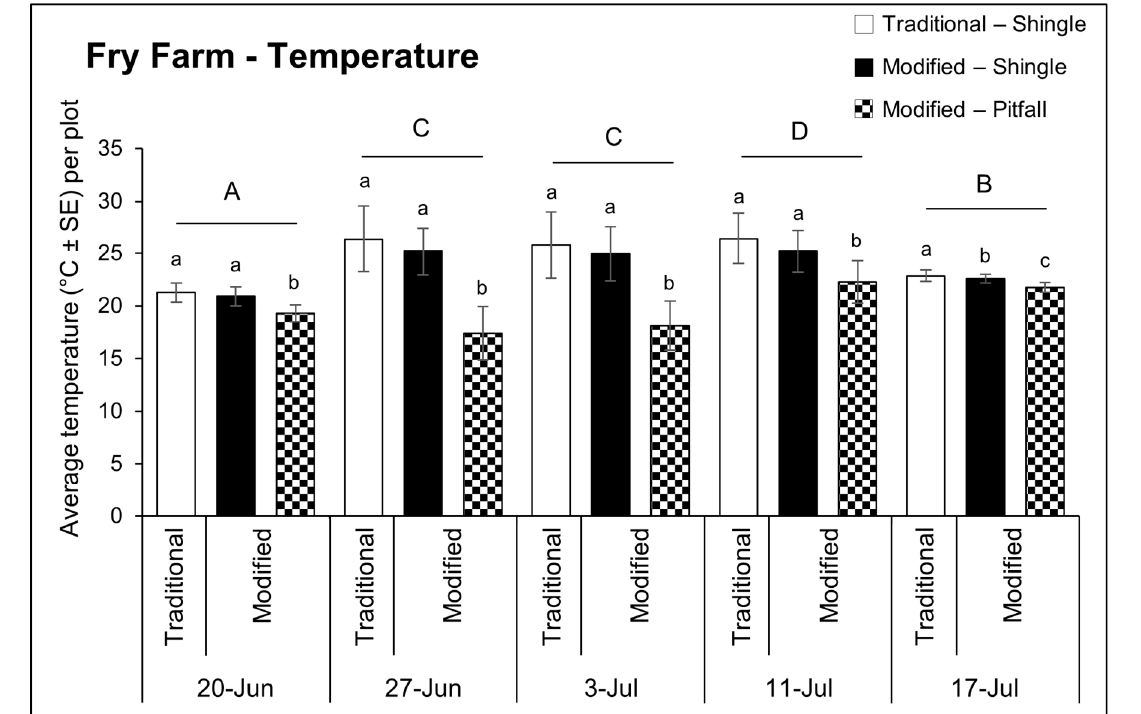
Figure 5. Average temperature recorded under each trap component including the traditional trap shingle (white bars), modified trap shingle (black bars) and modified trap pitfall trap (black and white checkered bars) for each sampling date in 2019, at Fry Farm in Wooster, OH, U.S.A. Uppercase letters represent significant differences ( p < 0.05) from multiple comparisons analyses comparing the average temperature for all traps and components per plot over time. Lowercase letters indicate significant differences ( p < 0.05) in the number of slugs found under each trap component for each sampling date.